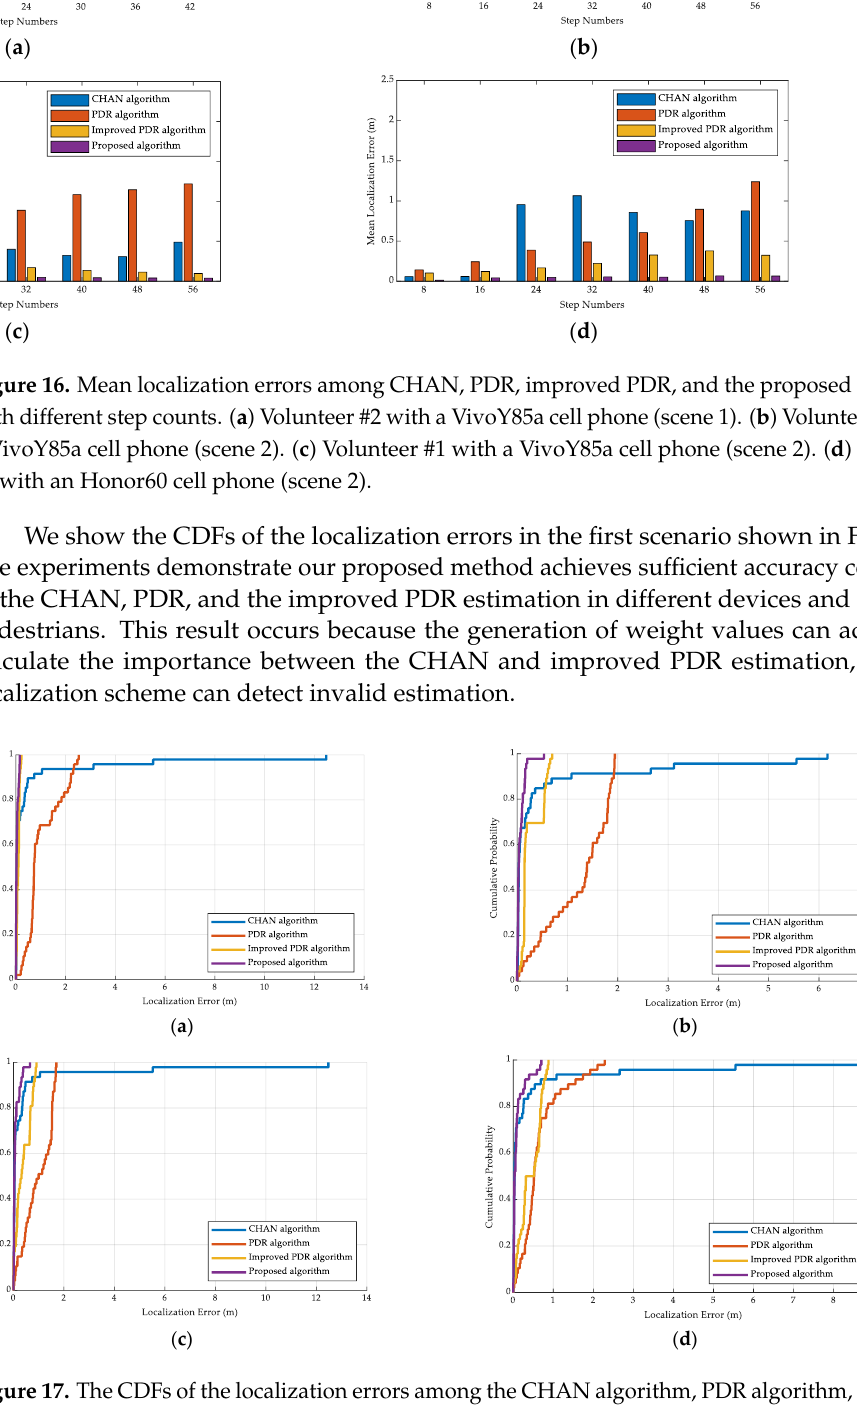
19 of 26 Figure 14. Localization path results among CHAN, PDR, improved PDR, and the proposed algo- rithm using the VivoY85a and Honor60 smartphones in the first scene. ( a ) Volunteer #2 with a Vi- voY85a cell phone in the first scene. ( b ) Volunteer #2 with an Honor60 cell phone in the first scene. Figure 15 shows the localization results using CHAN, PDR, improved PDR, and the proposed method with different height pedestrians at the trial sites. These results show that different heights cause different errors in the estimation algorithms. However, the proposed method achieves good accuracies with different user heights along the survey path because the proposed method can effectively compensate for the errors that different user heights create. ( a ) ( b ) Figure 15. Localization path results among CHAN, PDR, improved PDR, and the proposed algo- rithm with two different height pedestrians. ( a ) Volunteer #1 (height 155 cm). ( b ) Volunteer #2 (height 180 cm). Figure 16 demonstrates the mean localization errors between CHAN, PDR, dynamic improved PDR, and the proposed method for different devices, scenes, and step counting.